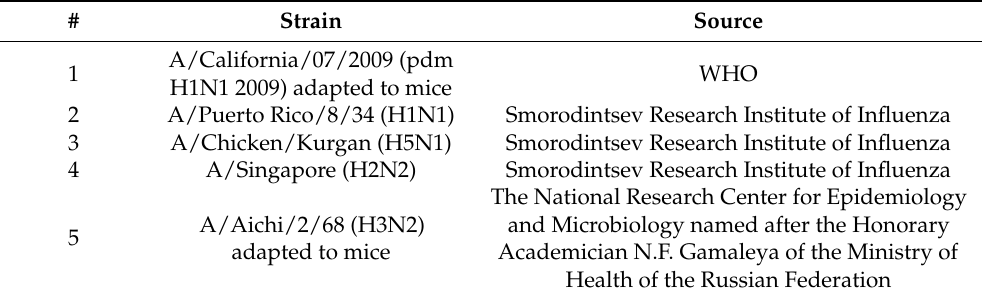
Table A1. The following viruses were used to stimulate influenza infection in mice.